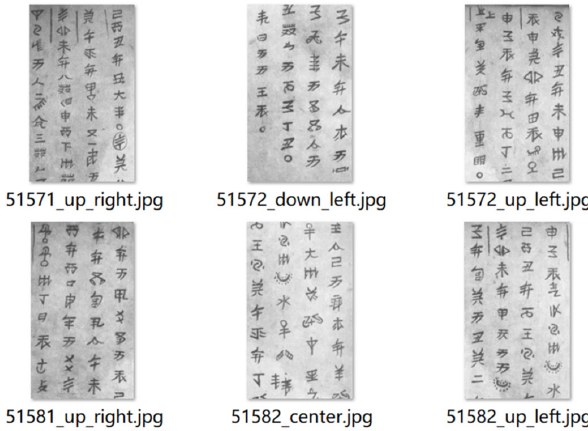
Figure 4. Image obtained via the image cropping method.